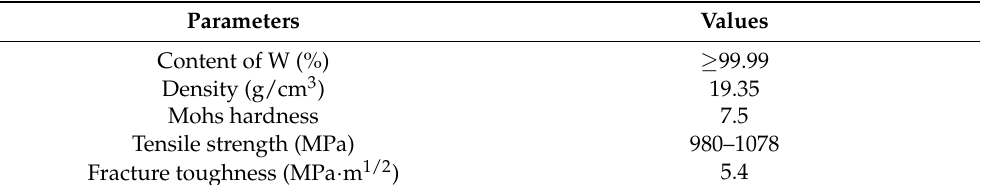
Table 1. Chemical composition and mechanical characteristics of tungsten.